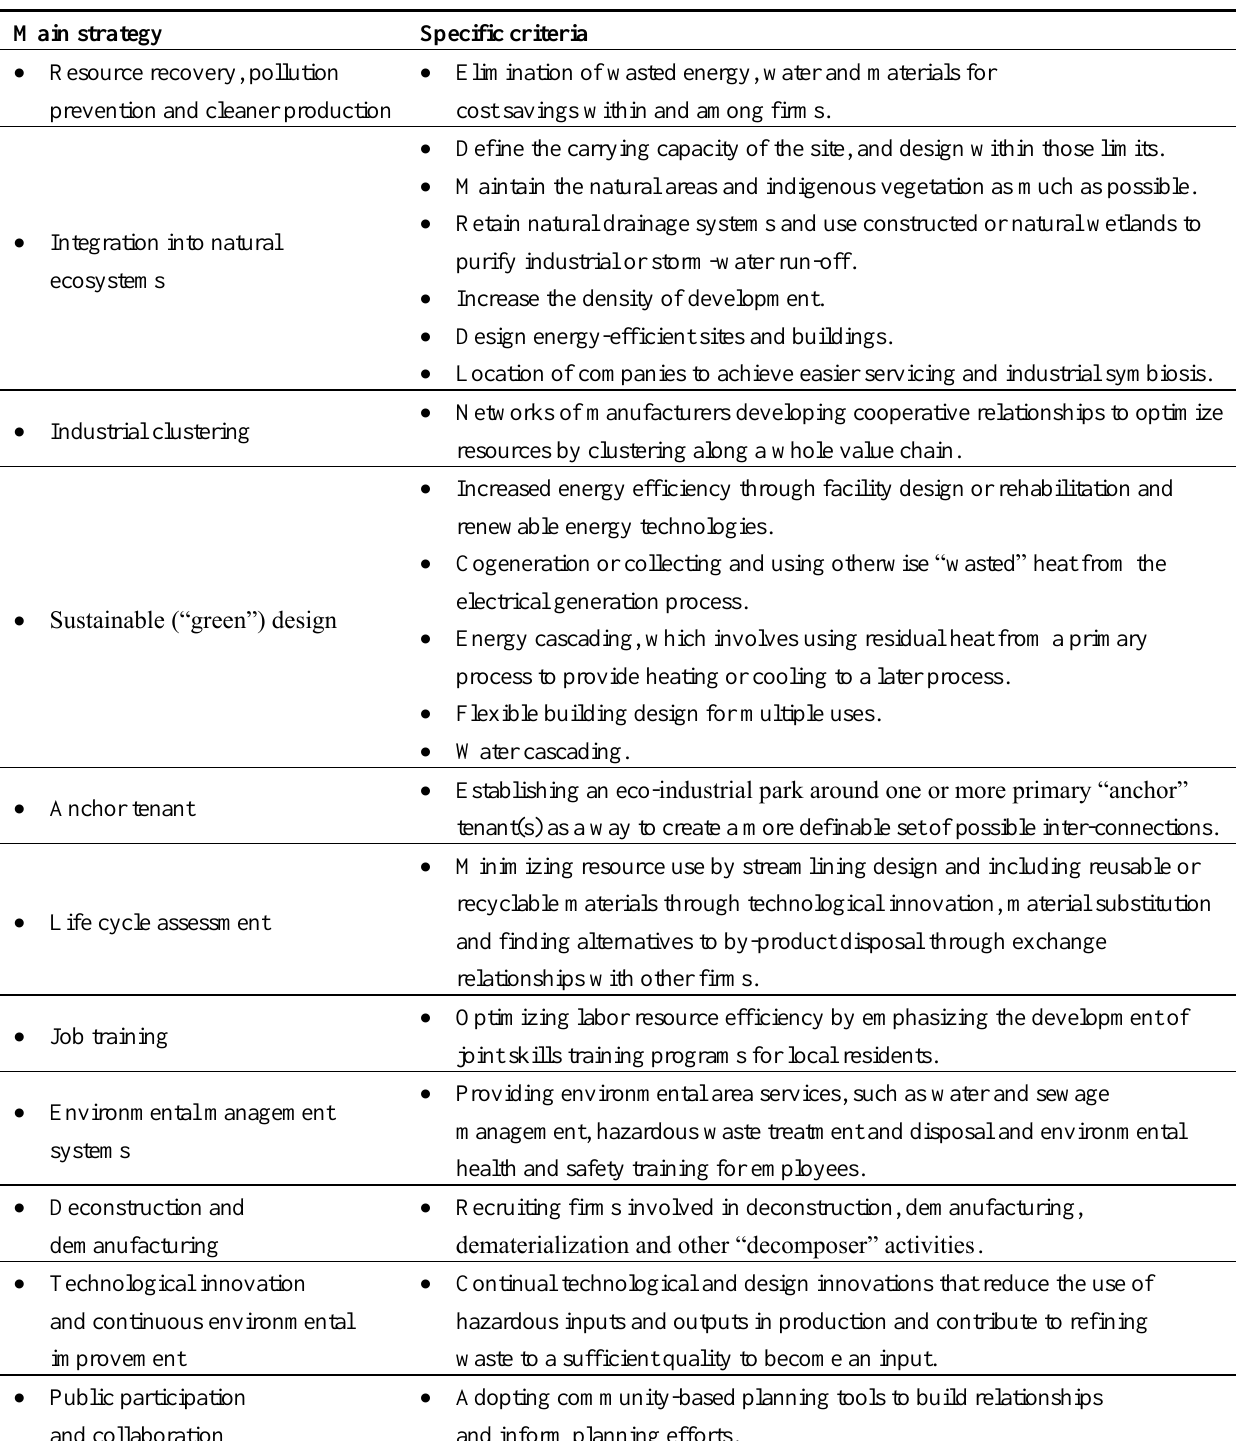
Table 1. The main strategies for eco-industrial park (EIP) development (data from Schlarb